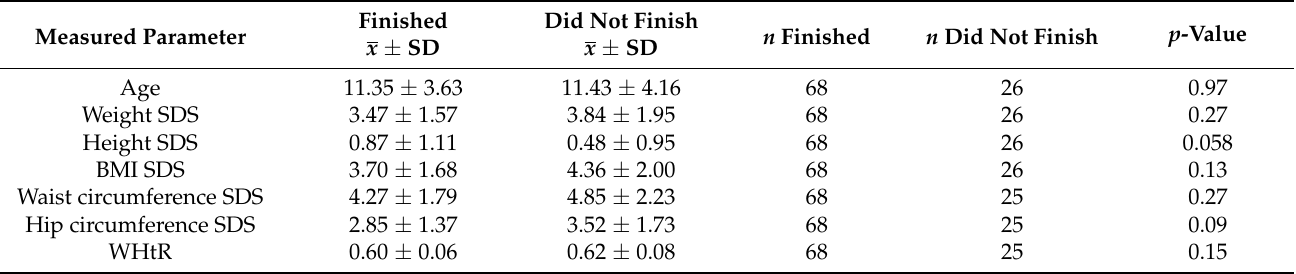
Table 1. Comparison of anthropometric parameters of children who completed the dietary interven- tion with those who did